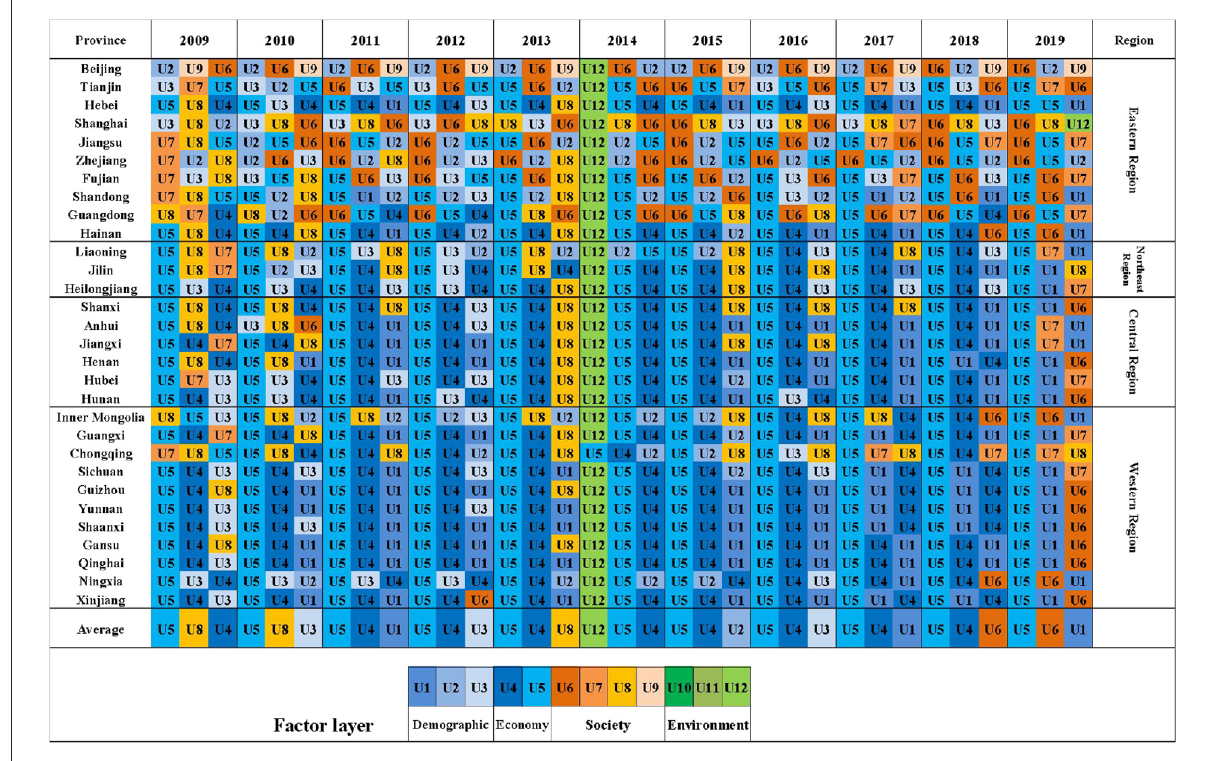
(1) There are regional imbalances in the level of LCD, TI,